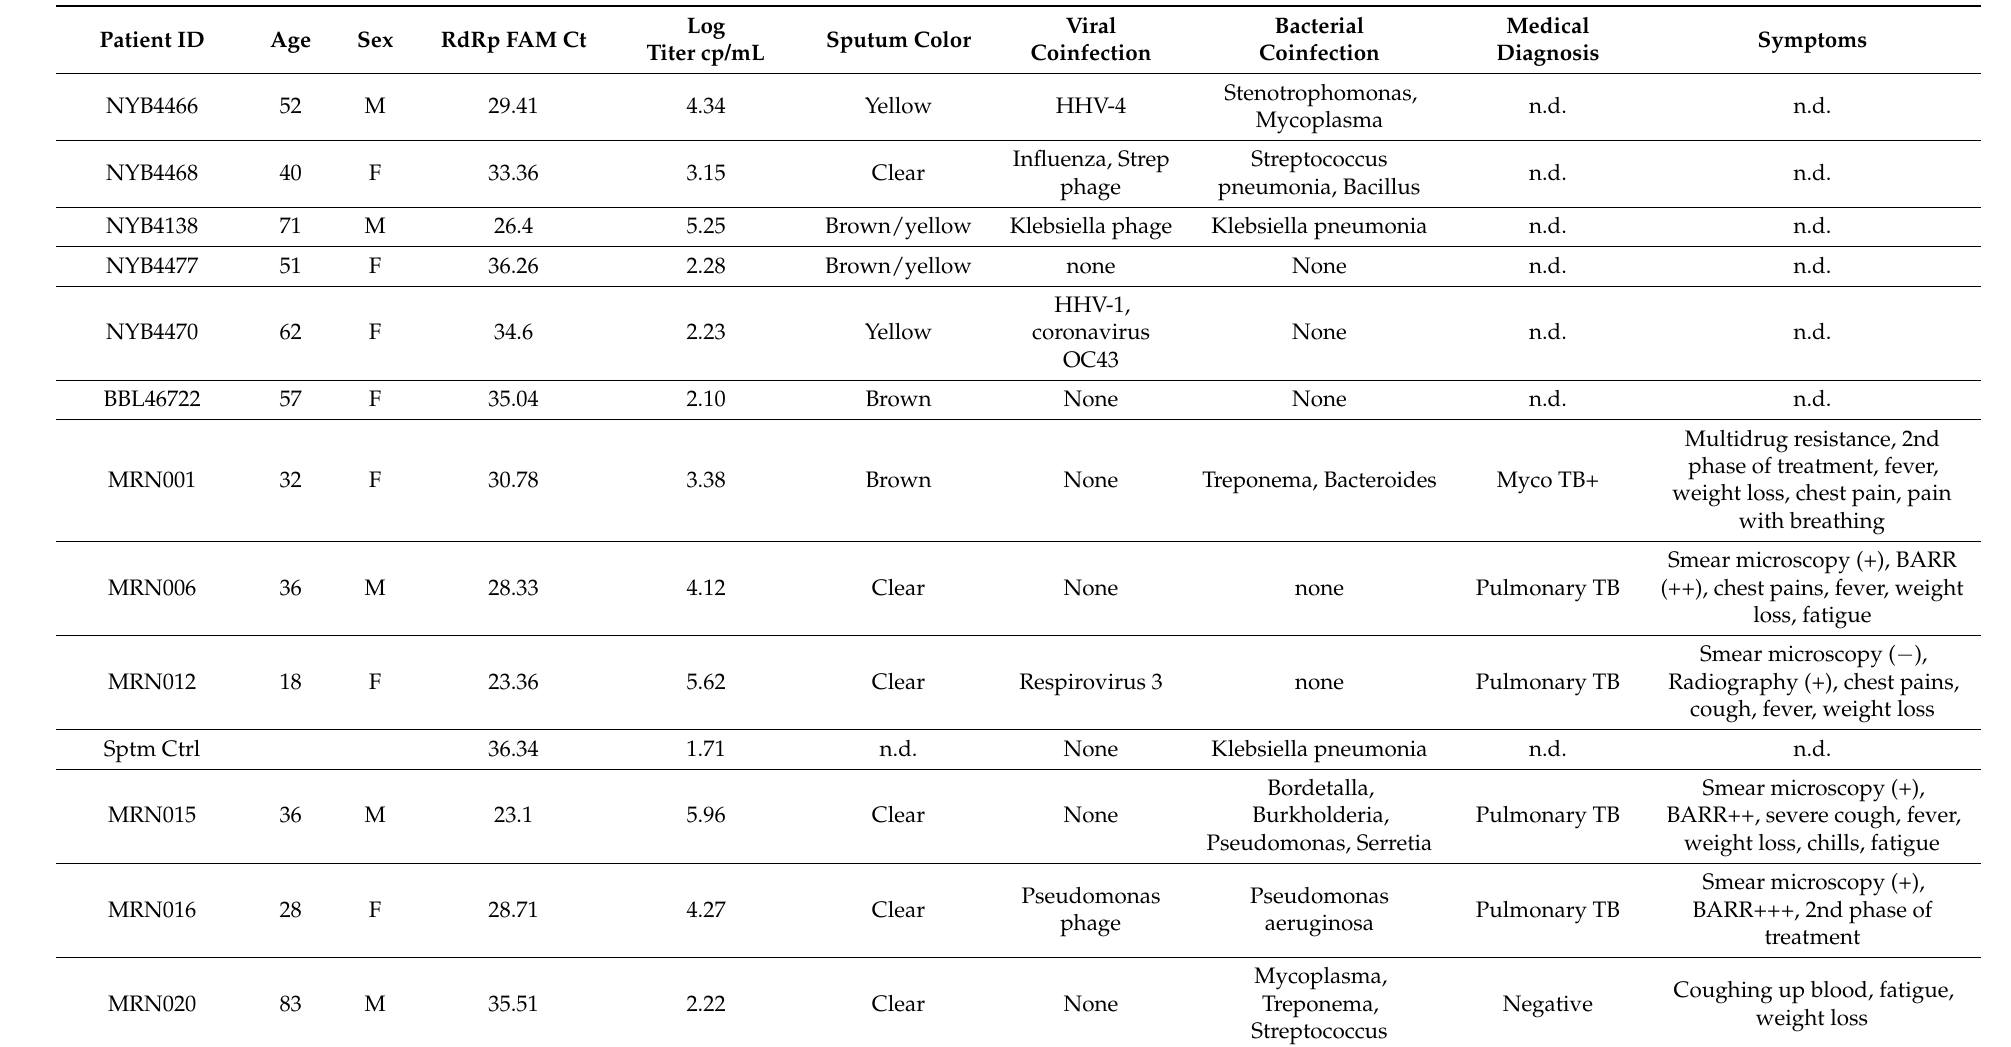
Table 2. mNGS results and clinical data for PBV